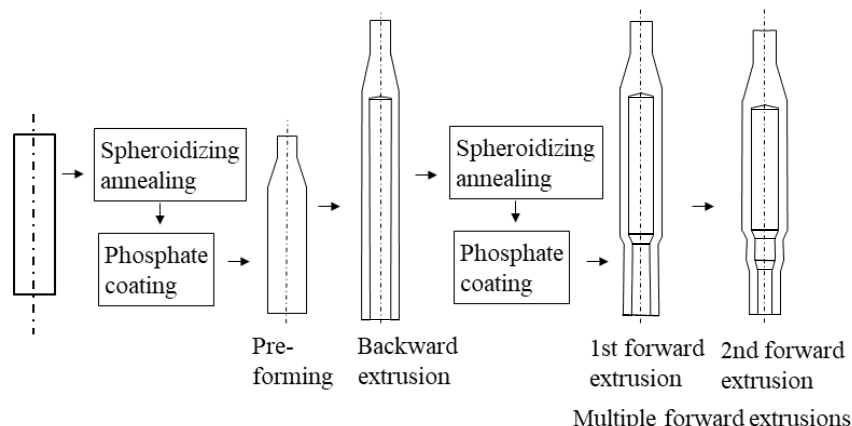
Figure 14. Sequence of cold-forging operations of hollow shaft parts.